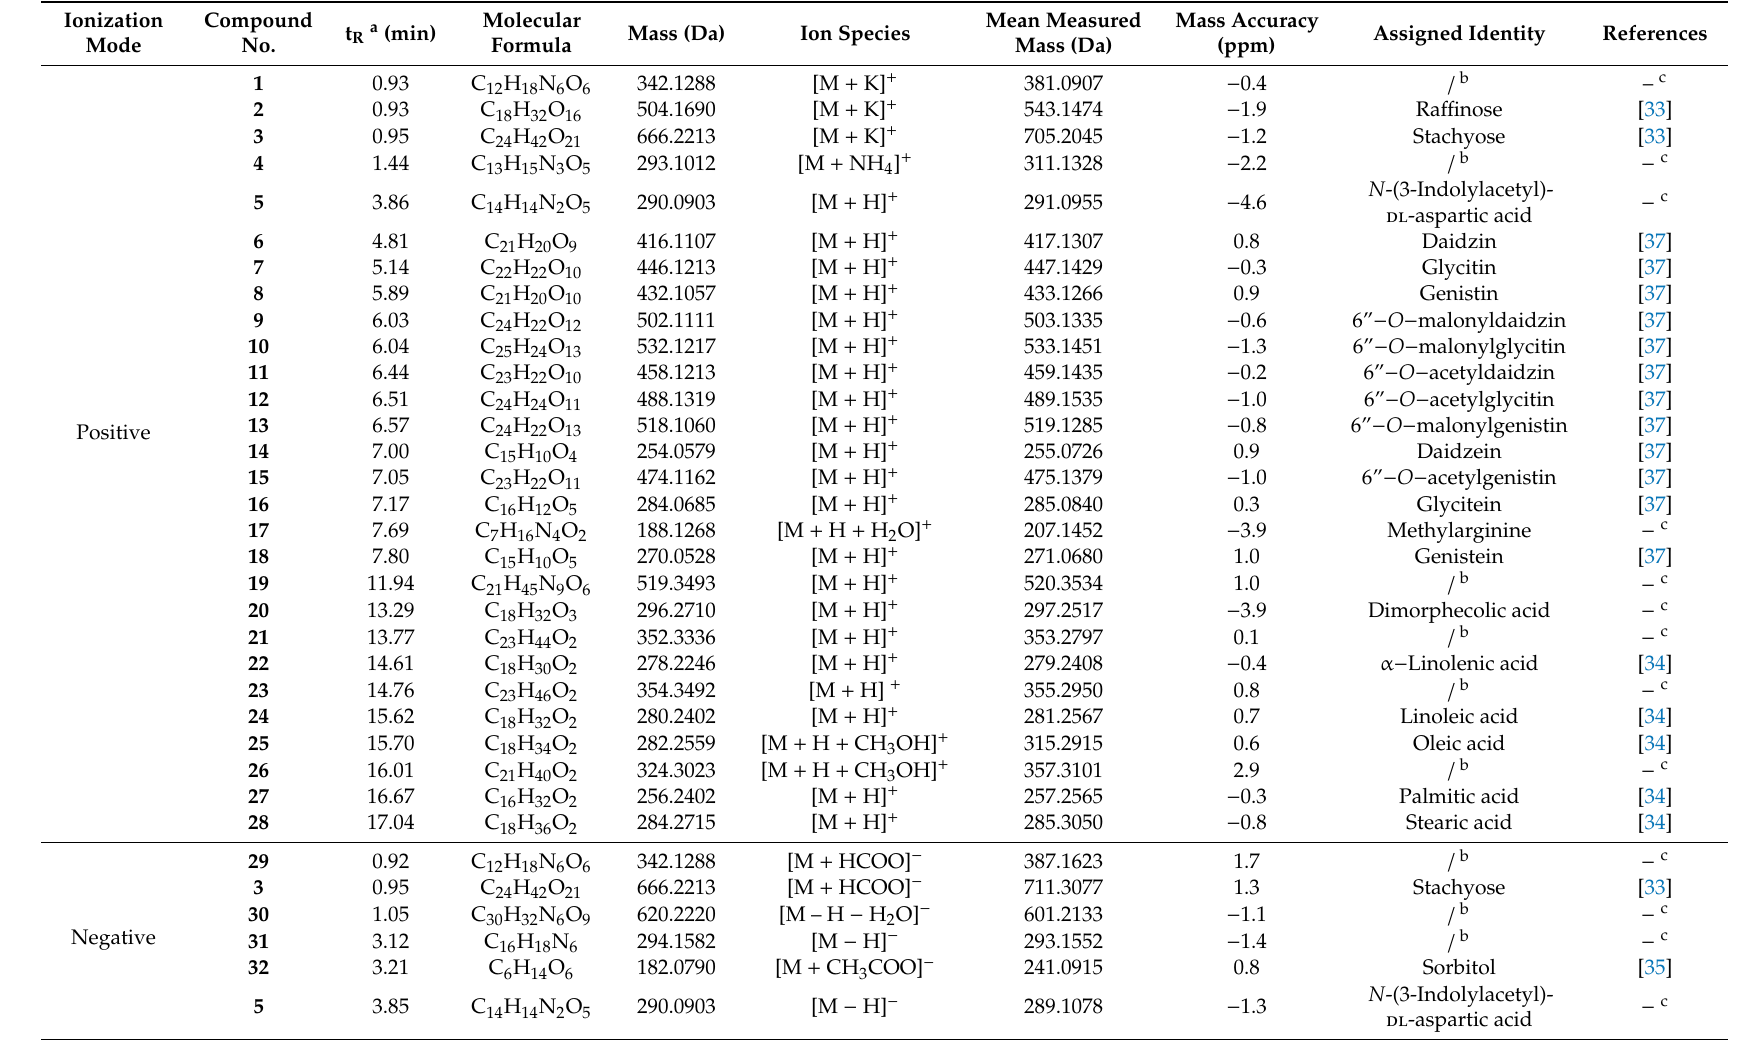
Table 1. Varied components putatively identified from soybean and Sojae semen praeparatum products in both positive and negative ion modes.